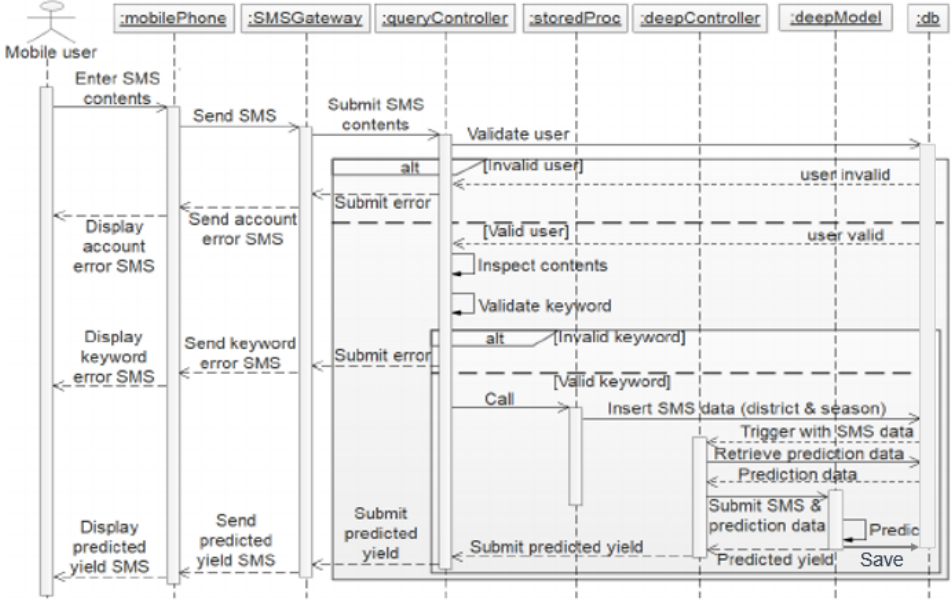
Figure 2. Sequence diagram for first request of maize yield prediction via